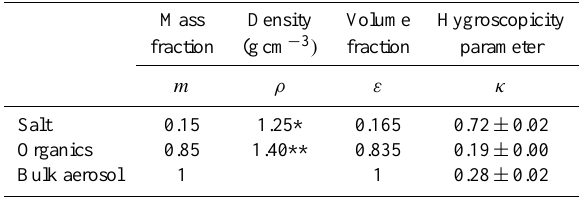
Table 2. Mass and volume fraction, density, and hygroscopicity of inorganic/organic components in the humid (RH ∼ 22%) TMA– NO 3